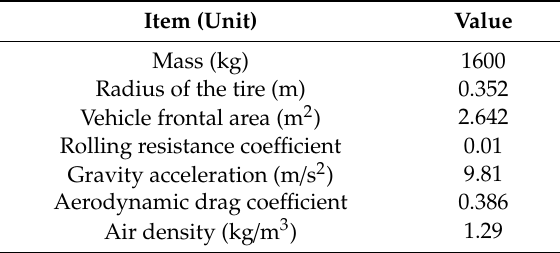
Table 1. Vehicle parameters for dynamic